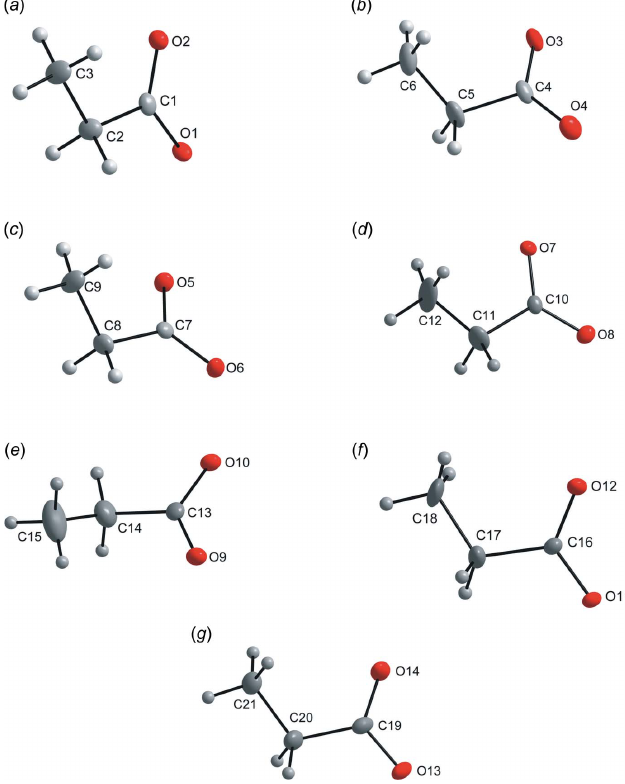
Symmetrycodes:(iii) (cid:4) x +1, (cid:4) y +1, (cid:4) z +1;(iv) x + 1 2 , (cid:4) y + 1 2 , (cid:4) z +1;(vi) (cid:4) x +1, y , (cid:4) z + 3 2 ; (vii) (cid:4) x + 1, (cid:4) y , (cid:4) z +